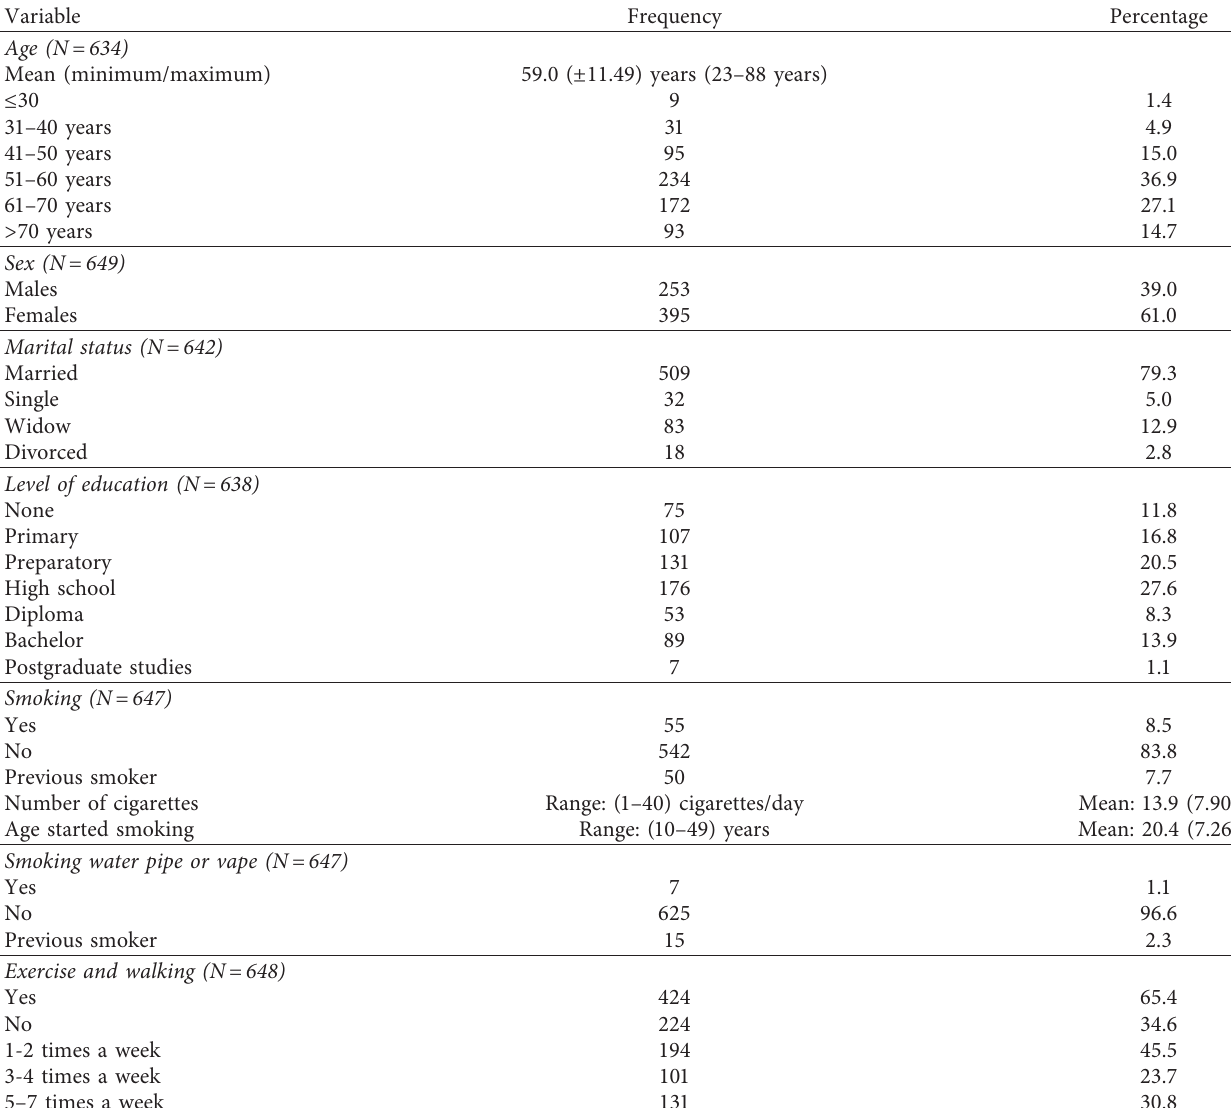
Table 1: Sociodemographic characteristics of the